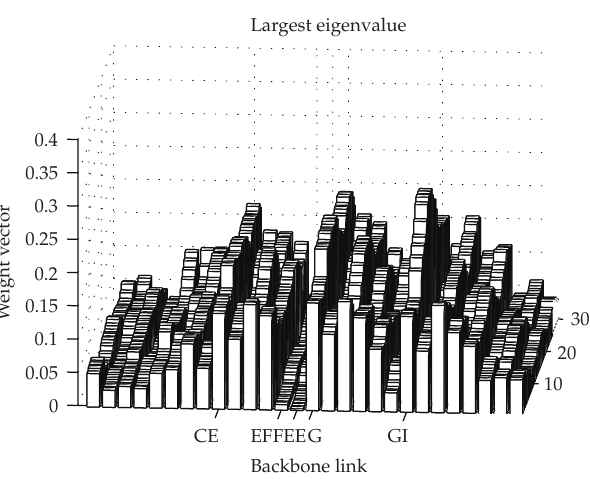
Figure 3: The tra ffi c patterns monitored by the largest eigenvalue.